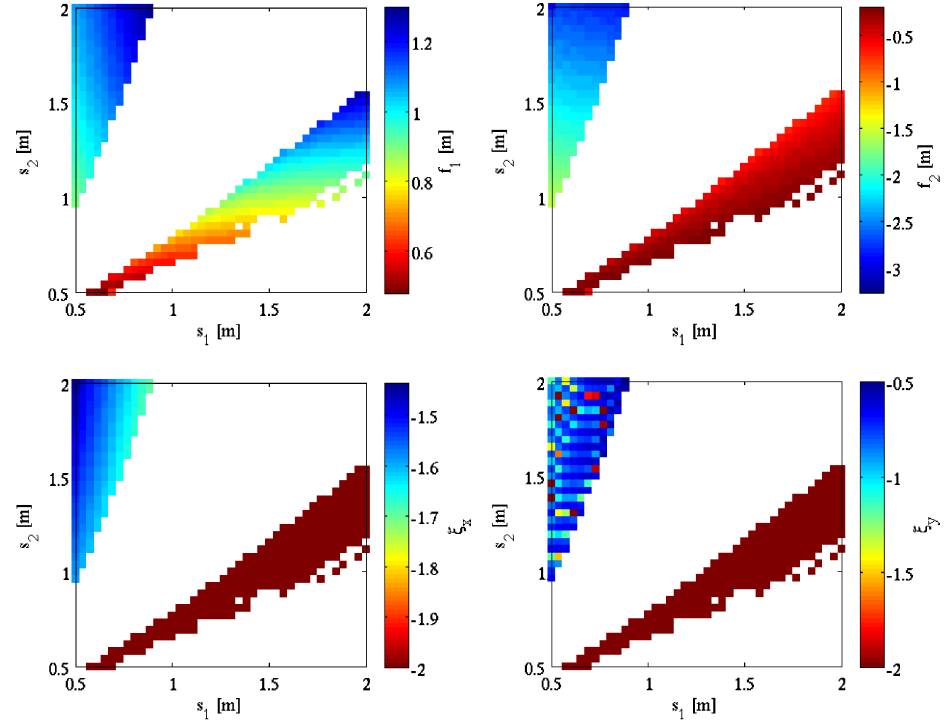
FIG. 3. Parametrization of the quadrupole focal lengths (top), f 1 (left) and f 2 (right) and the horizontal (bottom, left) and vertical (bottom, right) chromaticities with the drift spaces lengths, s 1 , s 2 providing optical stability.